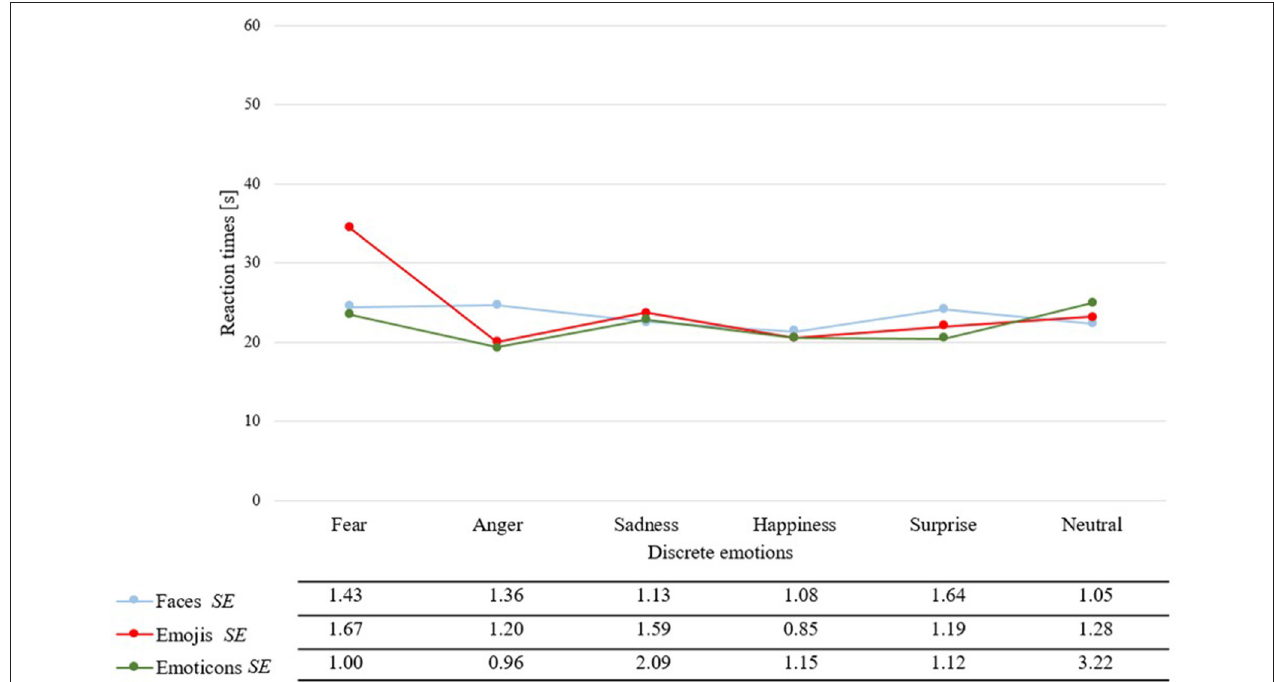
FIGURE 8 | Mean reaction times and standard errors ( SE ) in seconds for each stimulus category paired with each discrete